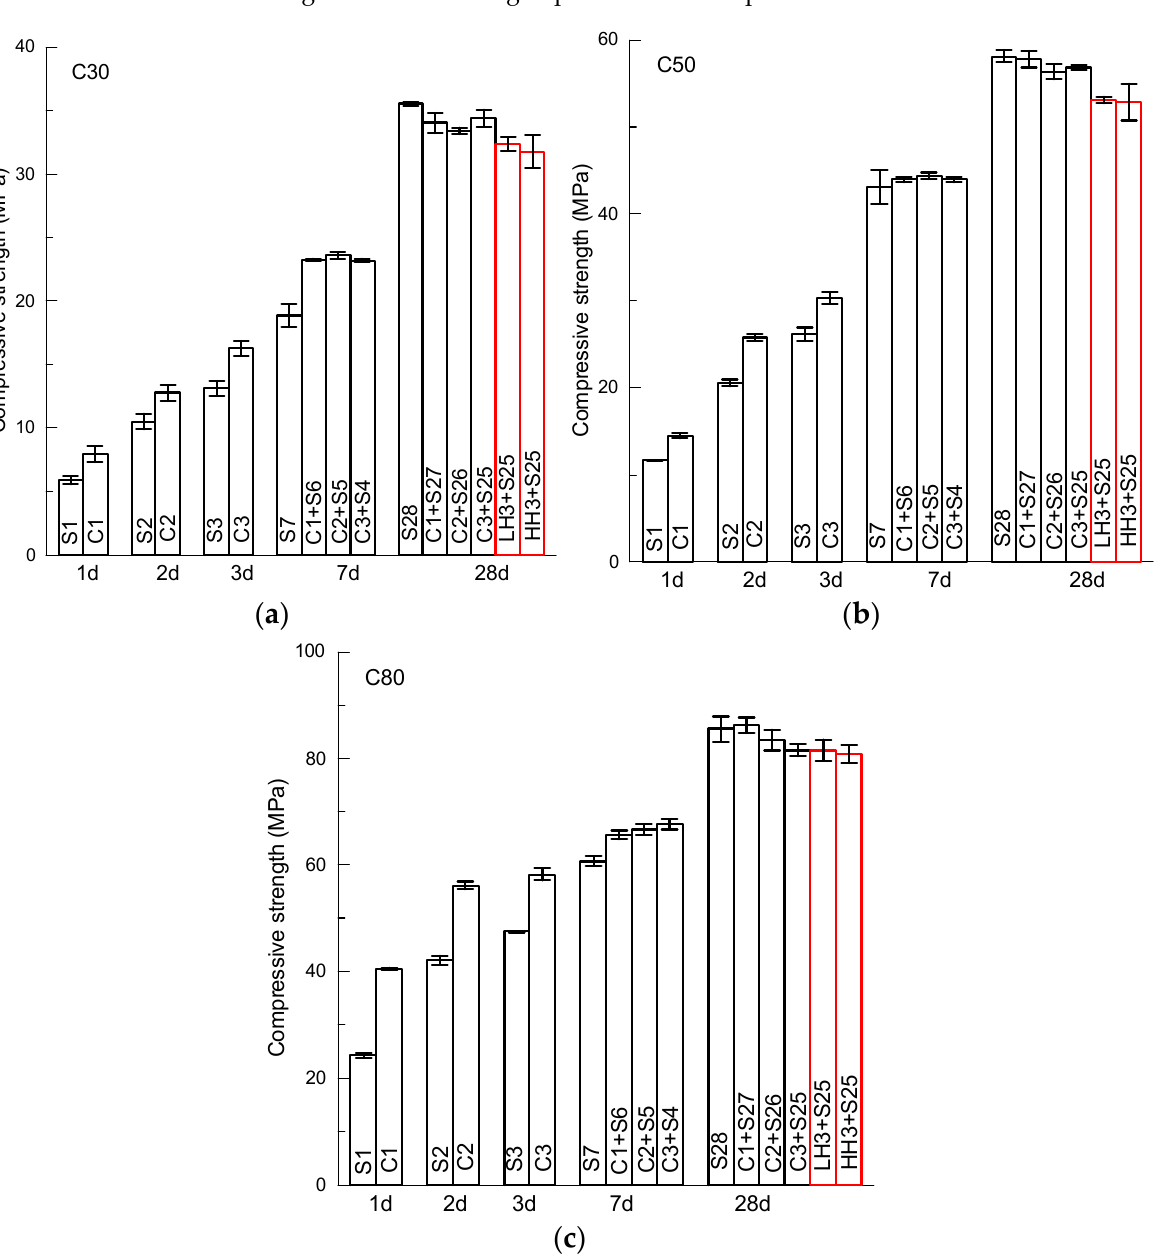
Figure 2. Development of temperature and relative humidity inside the curing box of concrete under insulation conditions ( a ) C30, ( b ) C50 and ( c ) C80.